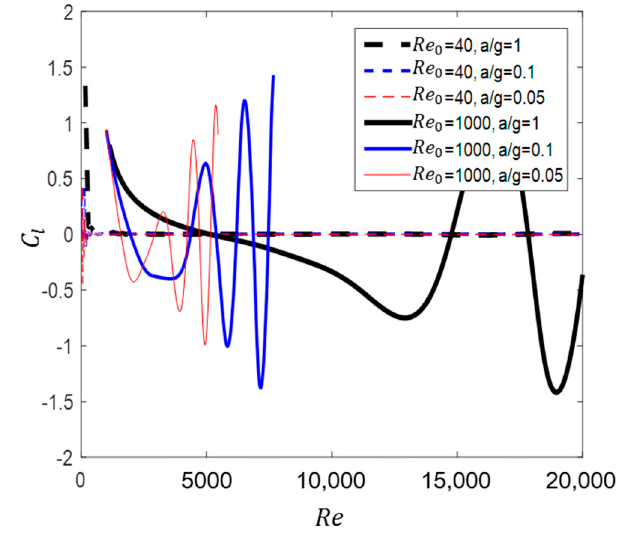
Figure 29. C l versus Re for flow past circular cylinder of two di ff erent initial Figure 29. 𝐶 (cid:3039) versus 𝑅𝑒 for flow past circular cylinder of two different initial velocity